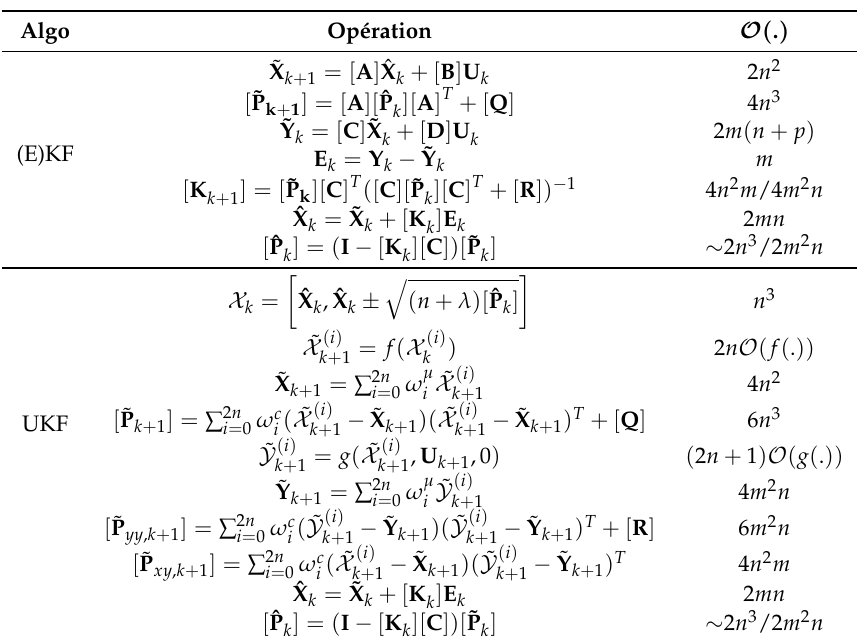
Table 4. Kalman filtering complexity depending on n , m and p .